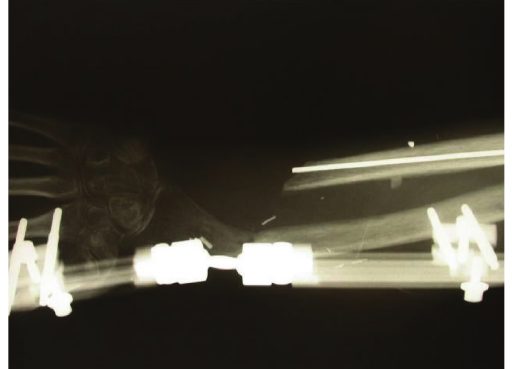
Figure 8: Followup at 1 year with 95% recovery of the flexor